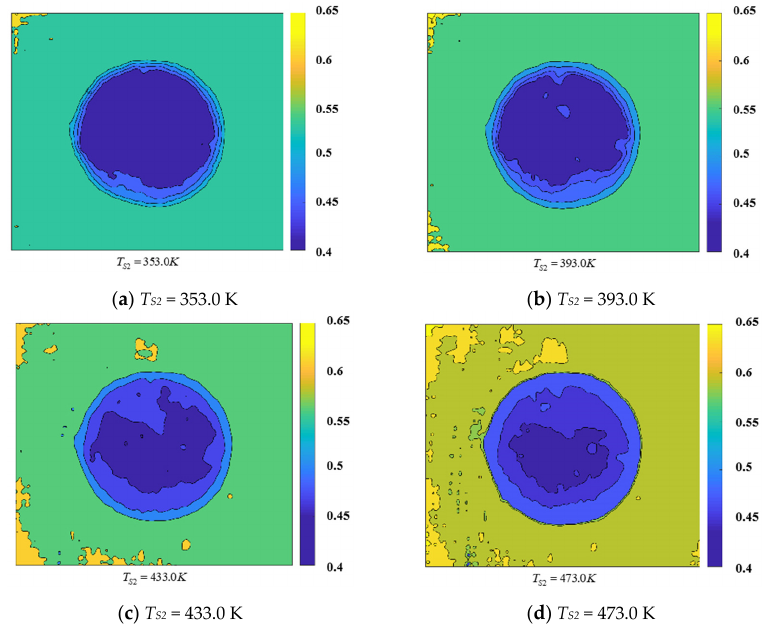
Figure 8. Calculation results of the bulge damage emissivity field.